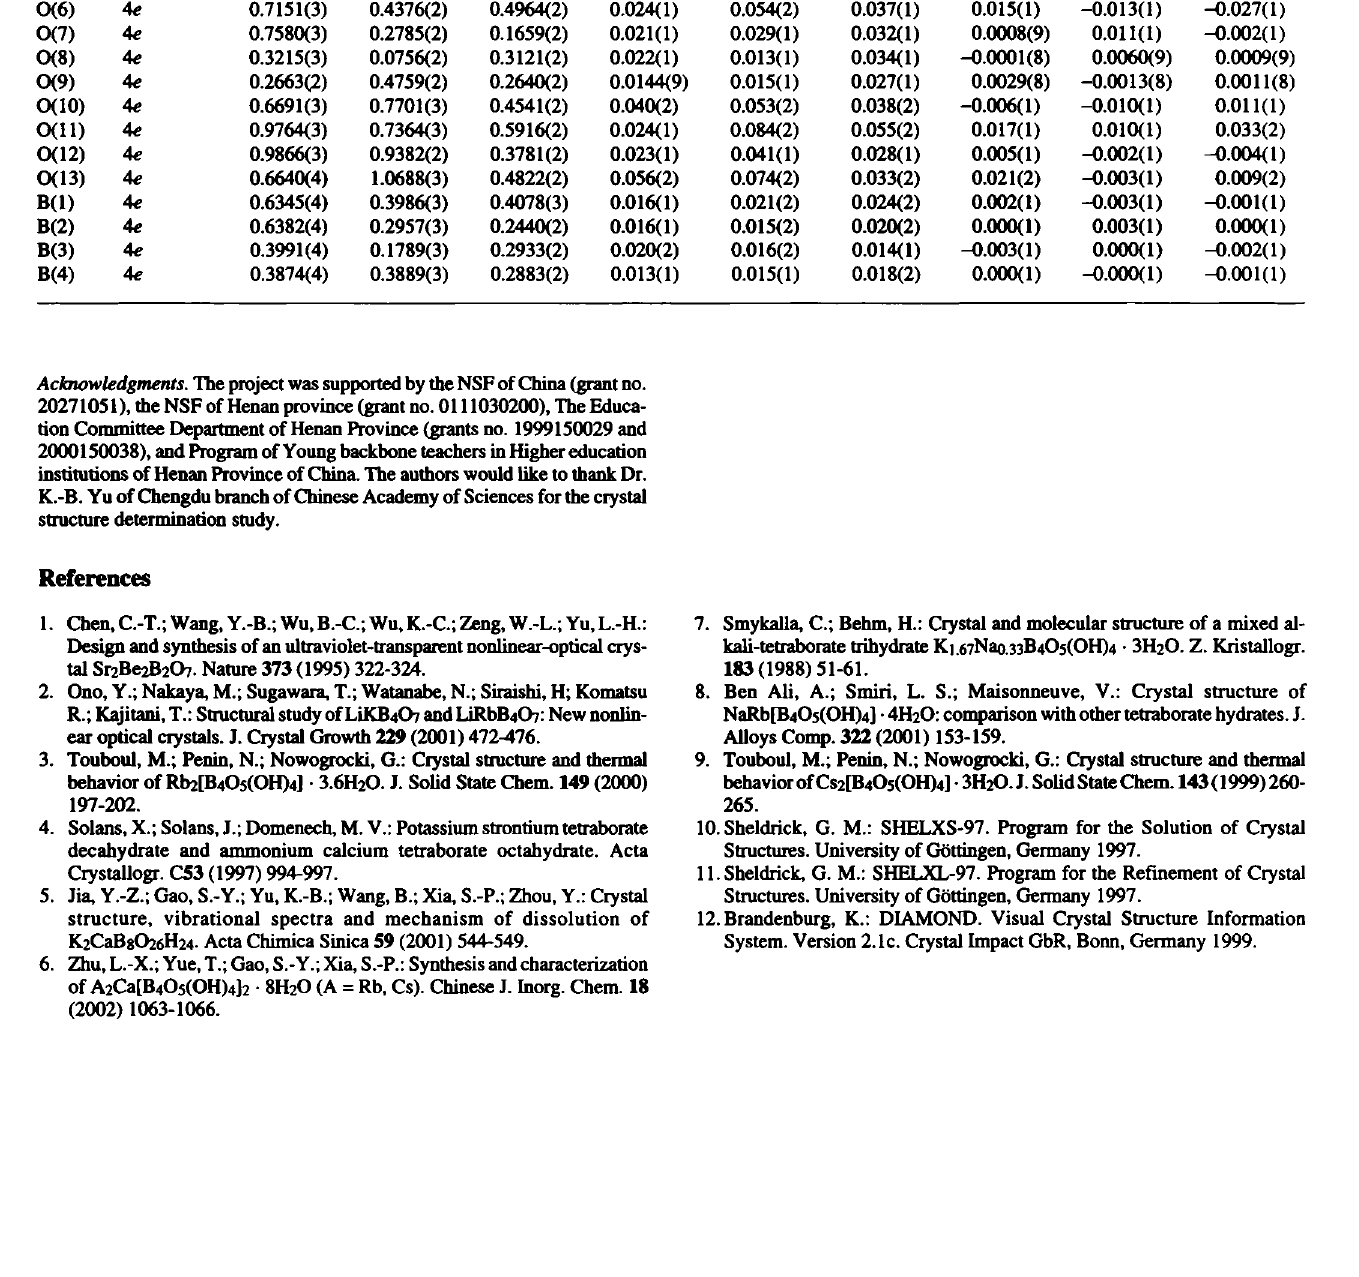
Table 3. Atomic coordinates and displacement parameters (in Â 2